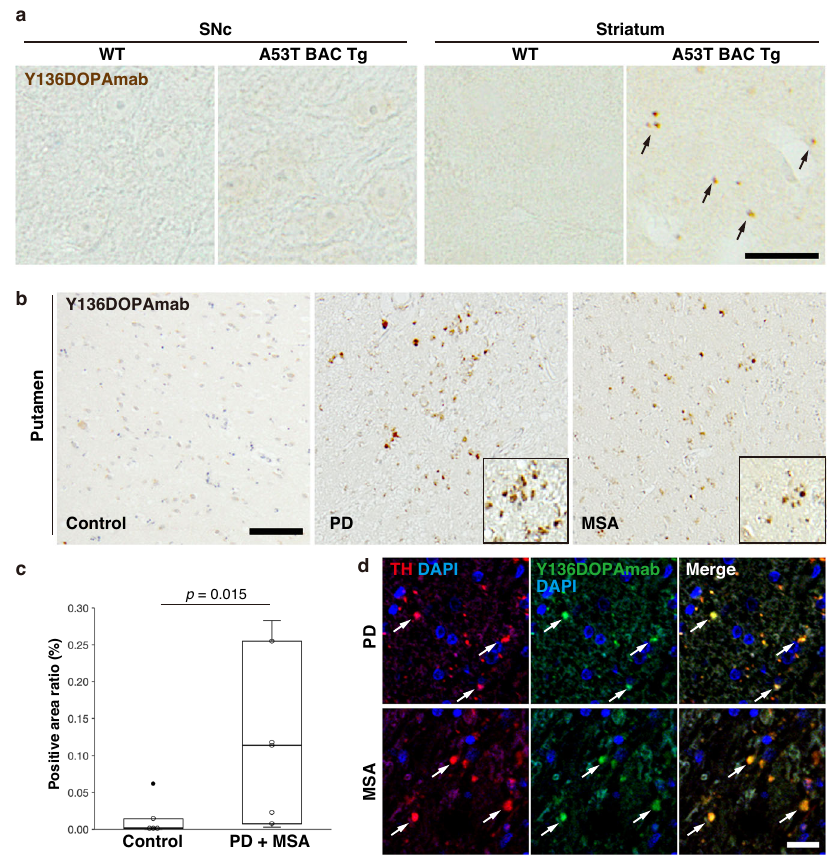
Fig. 3 | Y136DOPA modi fi cation in A53T BAC Tg mice and human α - synucleinopathies. a Y136DOPA signals (brown) in A53T BAC Tg mice. Eighteen- month-old wild-type (WT) and Tg mice were analyzed by immunohistochemistry staining using Y136DOPAmab. Tg mice, but not WT mice, showedpunctate signals in the striatum (black arrows),whereasthe cell bodies in the SNc didnotshow any signals in either mouse genotype (left panels). Scale bar: 20 µ